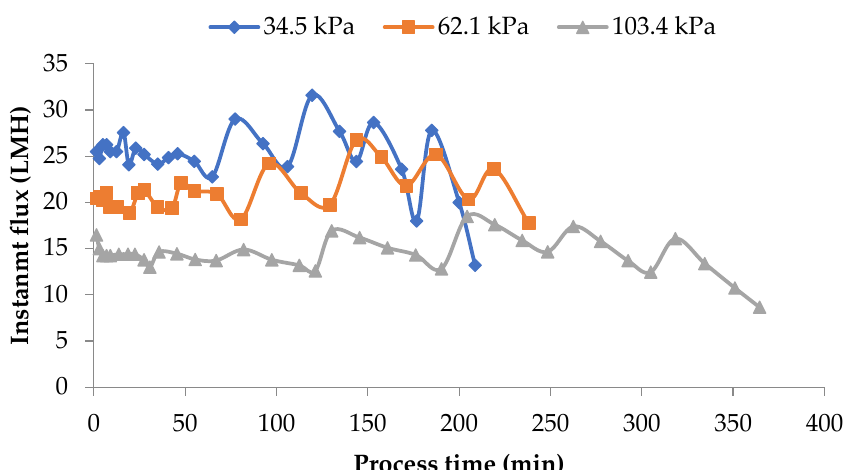
Figure 4. Instantaneous flux obtained from the lab-scale studies at the three pressures used. Diafiltra- tion was 150% of feed volume and was added at 6 intervals. Instantaneous fluxes are arrived at by measuring the permeate at various time intervals over the entire process run and averaging for that time interval. All the experiments were conducted at 24 ◦ C and 800 mL feed was concentrated to a final volume of 200 mL resulting in a volume reduction of 4 (VR). DF is the percentage of diafiltration based on the original feed volume.